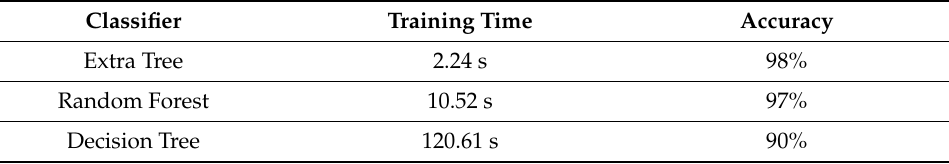
Table 4. Classifiers’ average training time and overall accuracy score by cross-validation using the parameter cv =